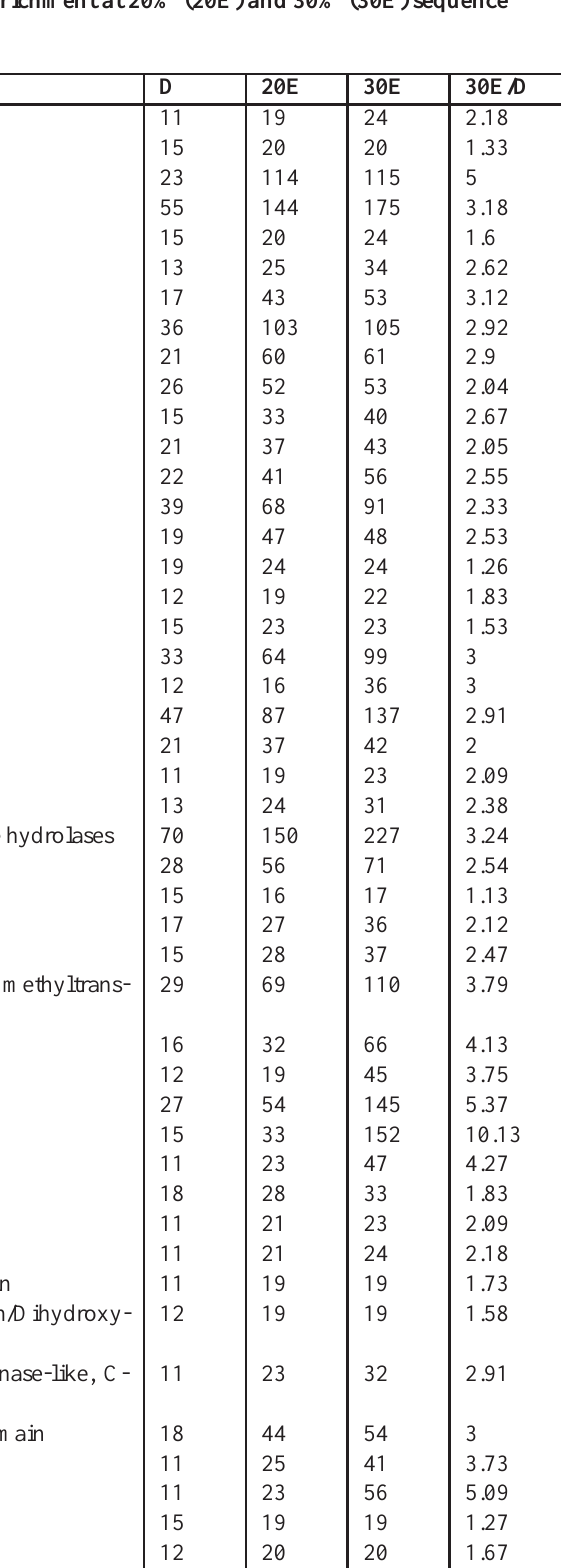
Table 3: Number of domains per superfamily (in the analysis that included multi domain proteins) from Astral20 before enrichment (D) and after enrichment at 20% (20E) and 30% (30E)